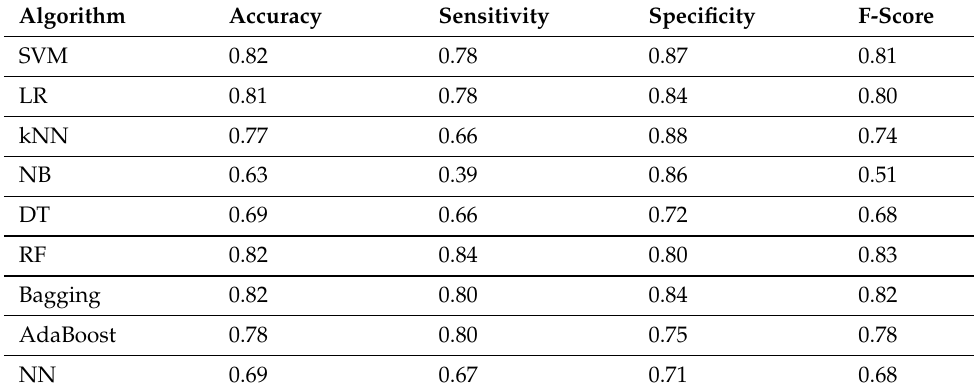
Table 4. Results with 70–30% train-test